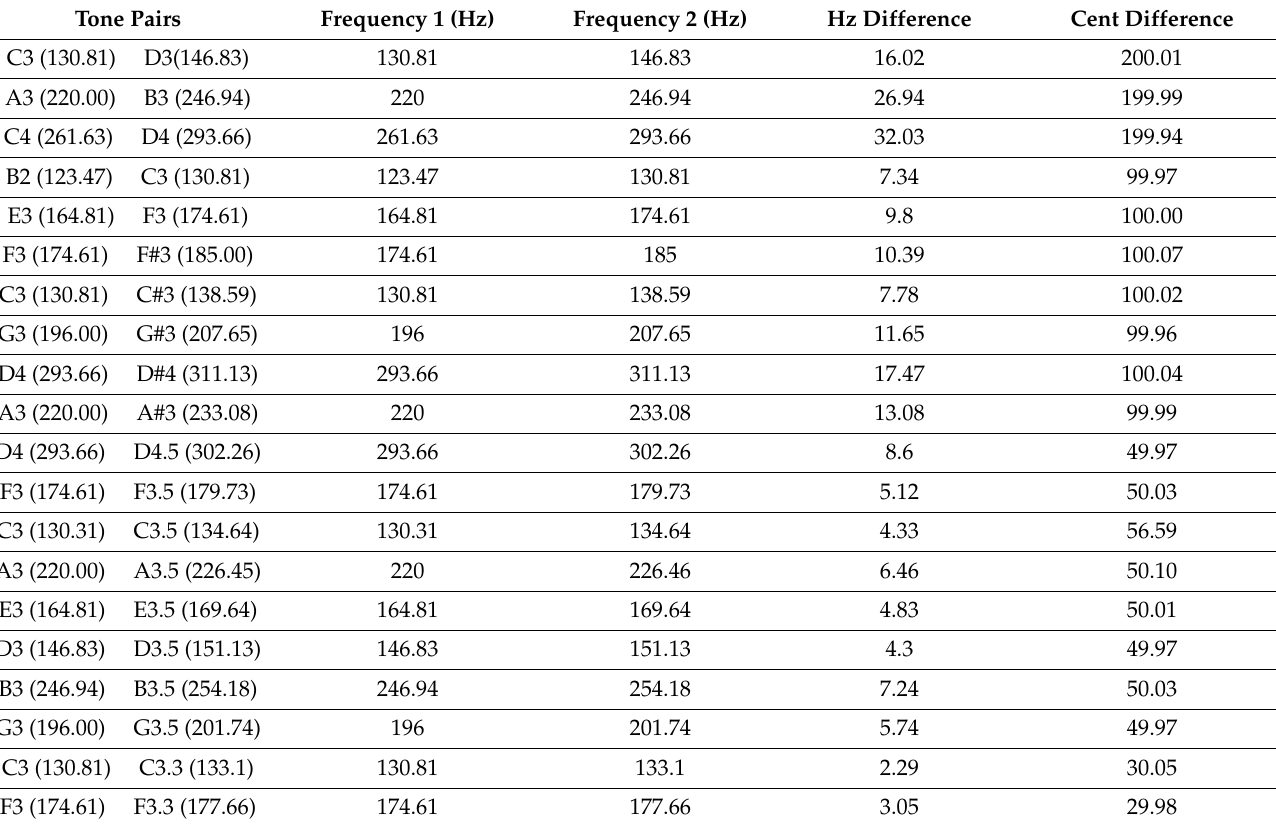
Table A1. Frequency of tone pairs of the